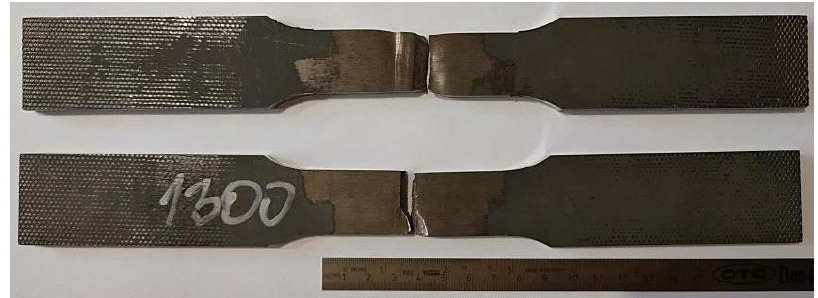
Figure 8. View of the specimens after tensile testing.